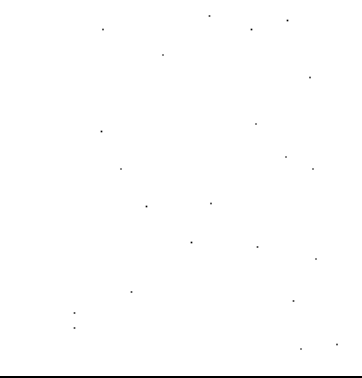
Fig. 8. Randomness of ITC